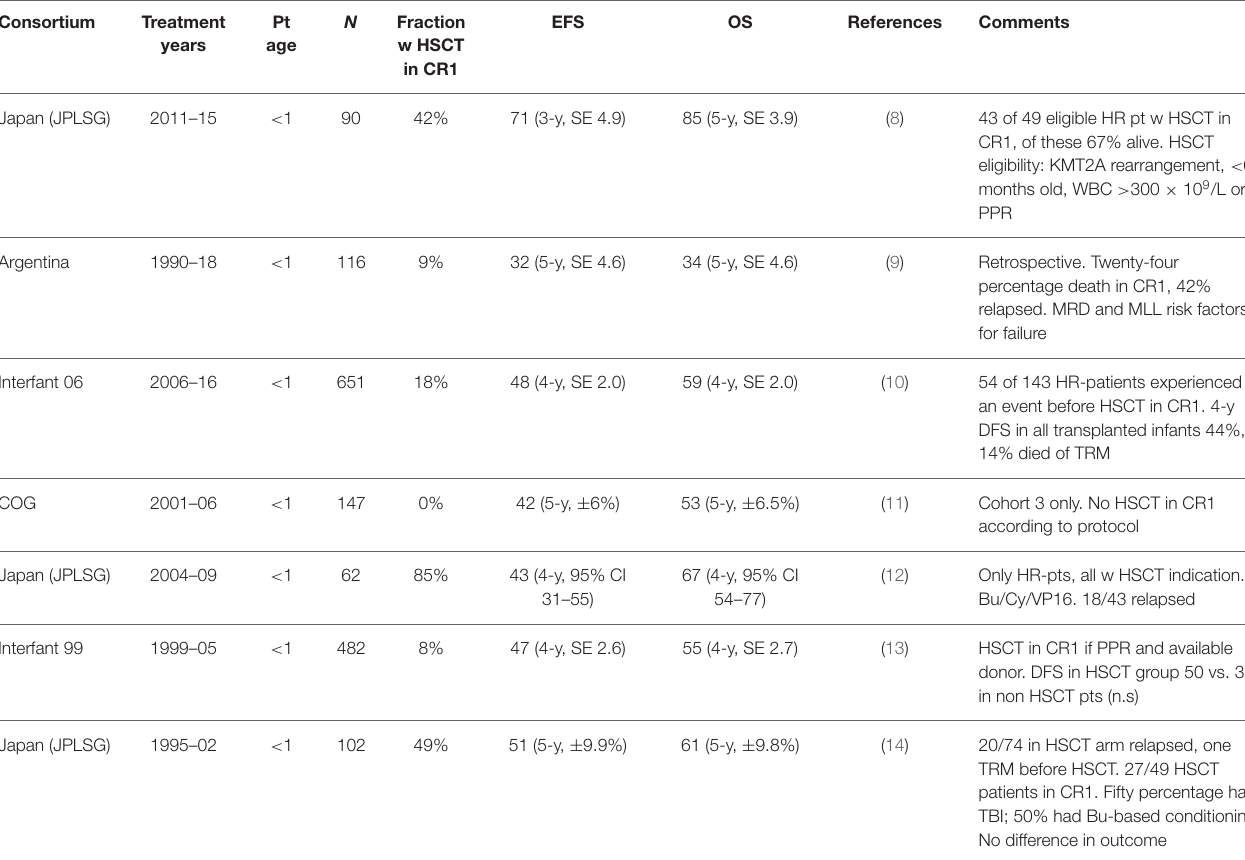
TABLE 1 | Results of trial protocols using HSCT in infants with ALL.